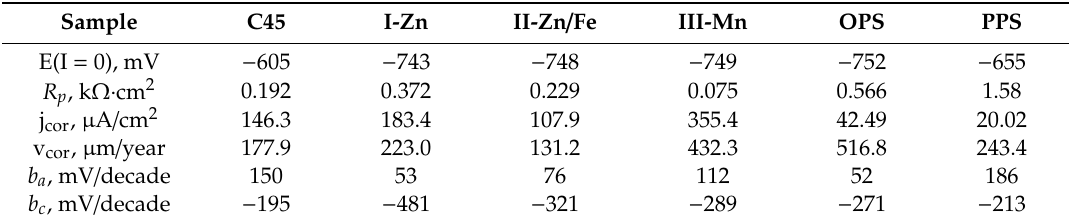
Table 4. Parameters of the instantaneous corrosion process for the samples studied in fire extinguishing solution